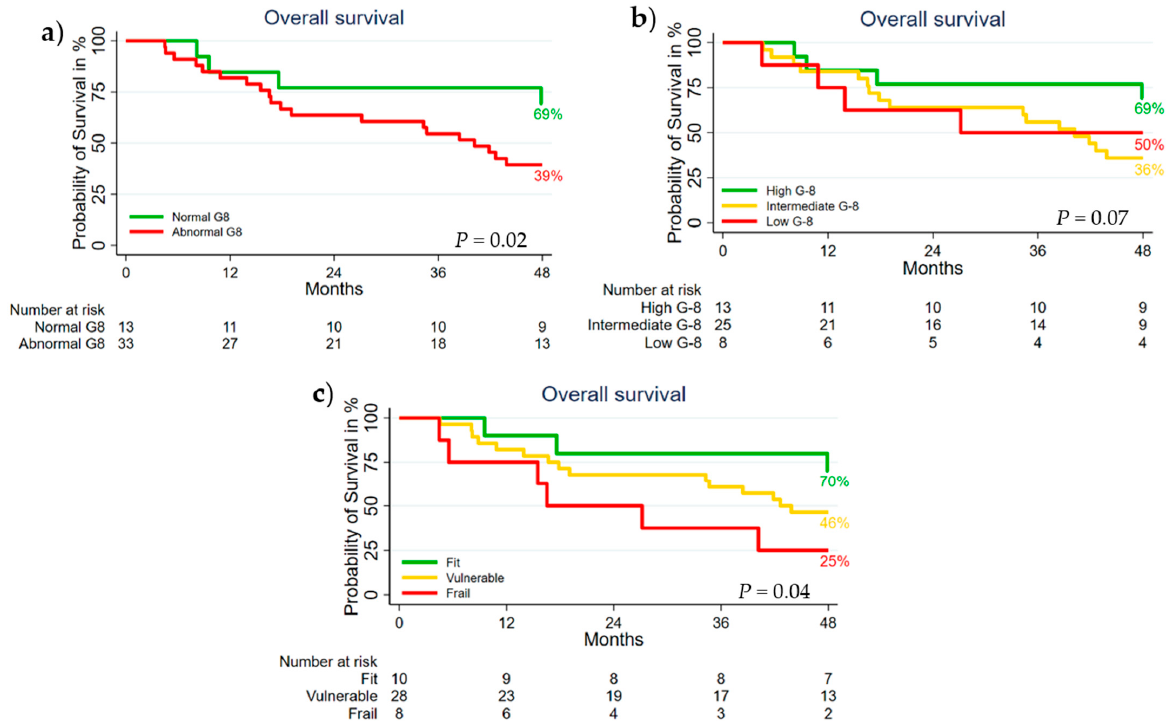
Figure 1. Kaplan–Meier plots of overall survival in ( a ) the normal vs. abnormal G-8 groups, ( b ) the high, intermediate, and low G-8 groups, and ( c ) the fit, vulnerable, and frail G-8 and HGST combination groups. Cancers 2021 , 13 , x